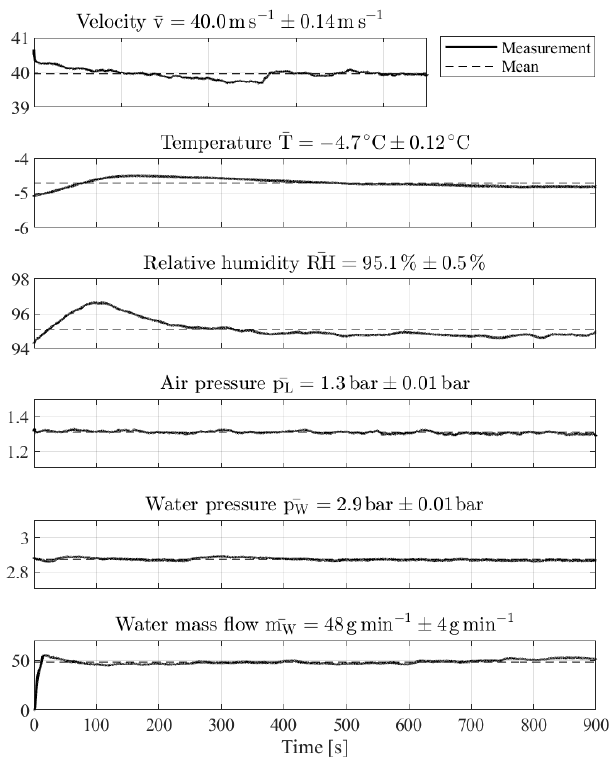
Figure 4. Example test case showing the stability of the wind tunnel conditions over a 15min test